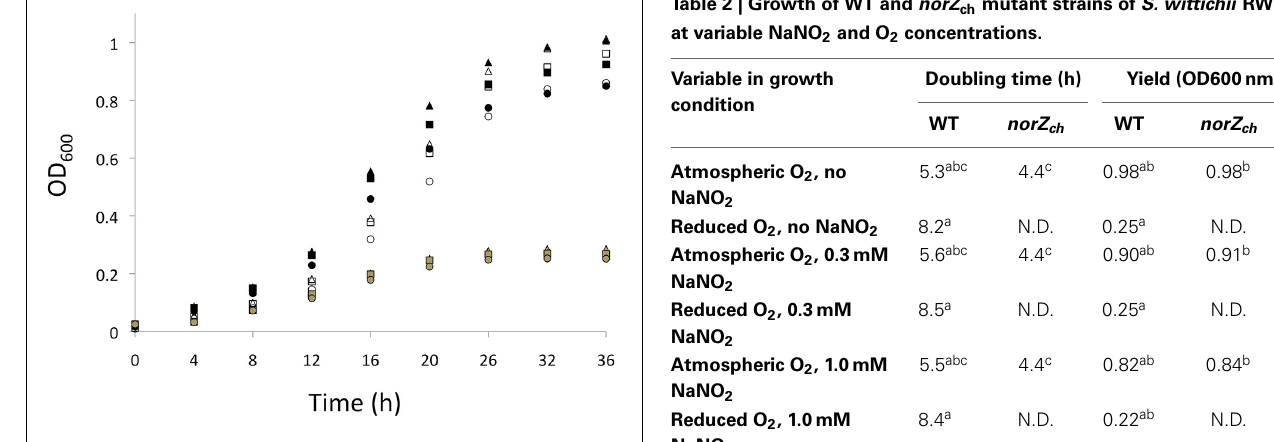
FIGURE 1 | Growth (OD 600 ) measured over time (h) for S. wittichii RW1 WT cultures initiated at atmospheric O 2 (black symbols) or reduced O 2 (gray symbols), and for norB ch mutant S. wittichii RW1 cultures initiated at atmospheric O 2 (white symbols). Triangles = 0mM added NaNO 2 , squares = 0.3mM added NaNO 2 , and circles = 1mM added NaNO 2 . Points on the growth curves represent averaged values from 5 independent experiments for each incubation condition.